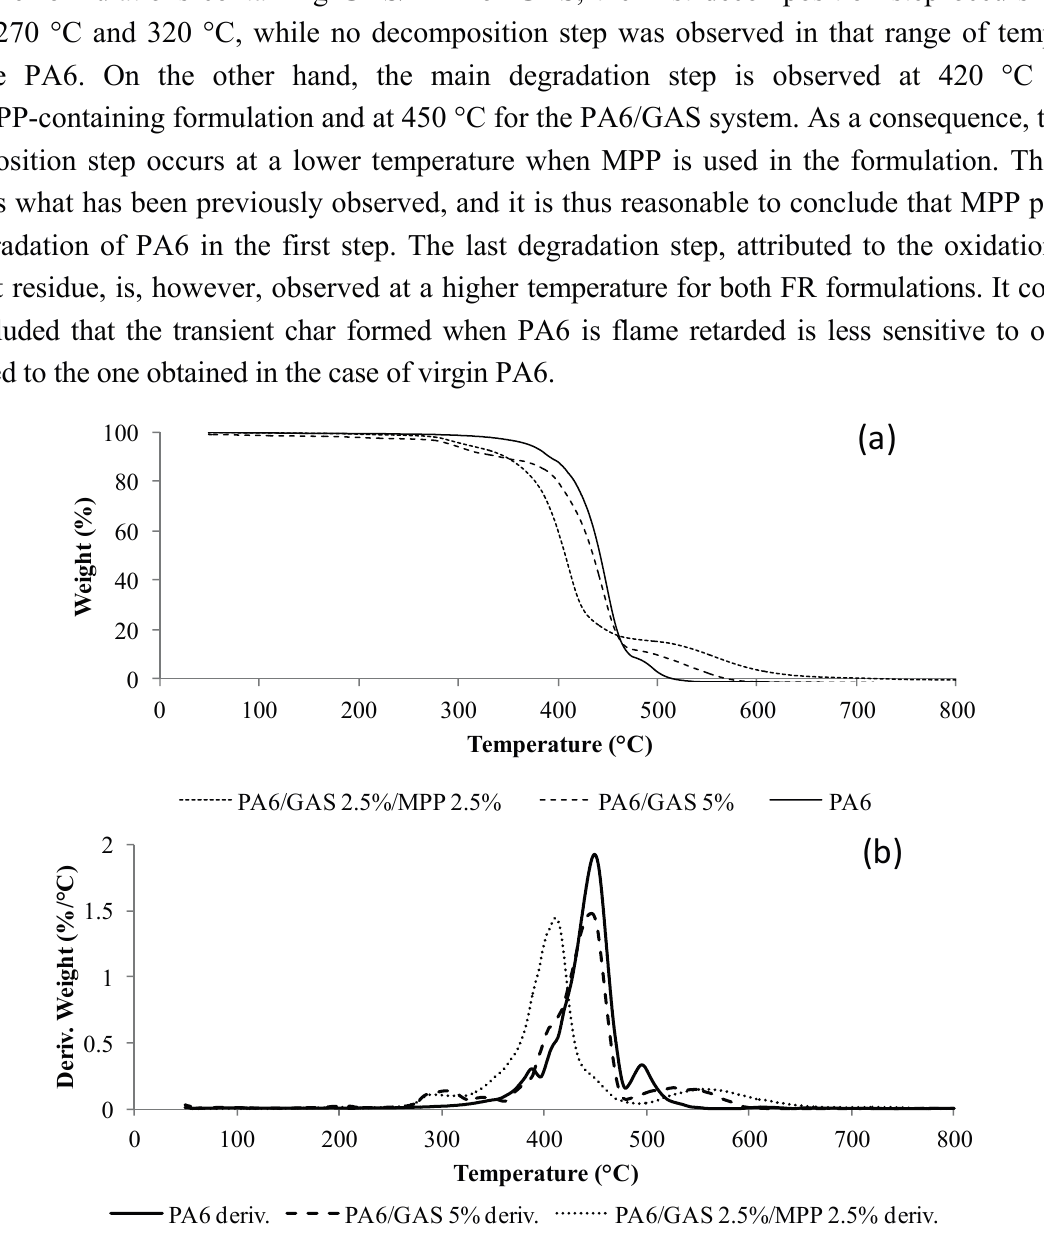
Figure 5. TG ( a ) and DTG curves ( b ) of PA6, and PA6/GAS 5% and PA6/2.5%/MPP 2.5% formulations (10 °C/min, air). Deriv. corresponds to